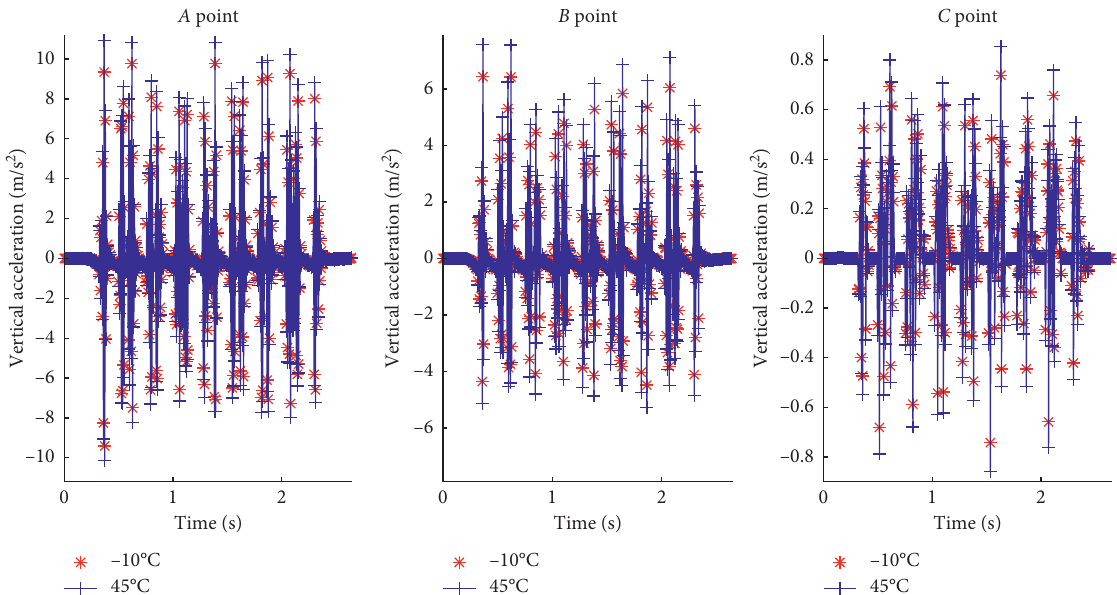
Figure 9: The simulated vertical acceleration under the temperature of − 10 ° C and 45 ° C with the speed of 350km · h − 1